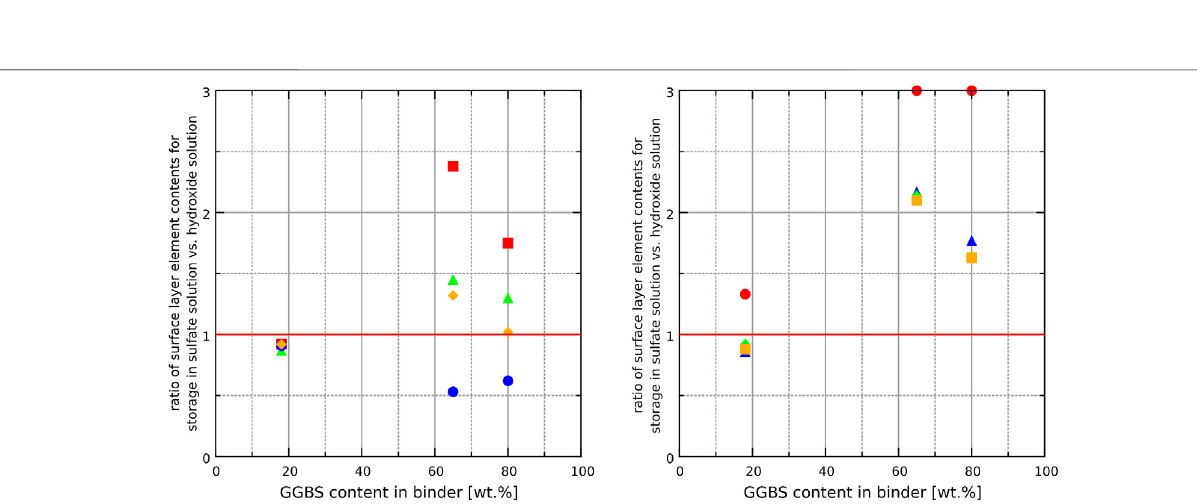
Frontiers in Materials |